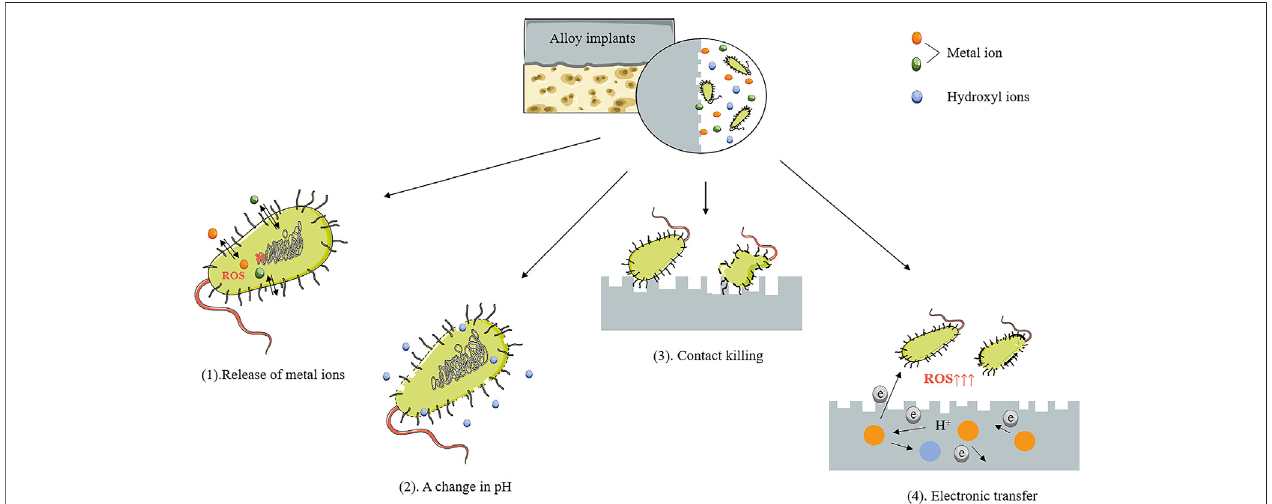
FIGURE 1 | Antibacterial mechanism of Mg-, Zn-, and Fe-based alloys as orthopedic implants. Presently, the proposed antibacterial mechanisms mainly include four aspects: (1) release of metal ions, (2) a change in pH, (3) contact killing, and (4) electronic transfer.